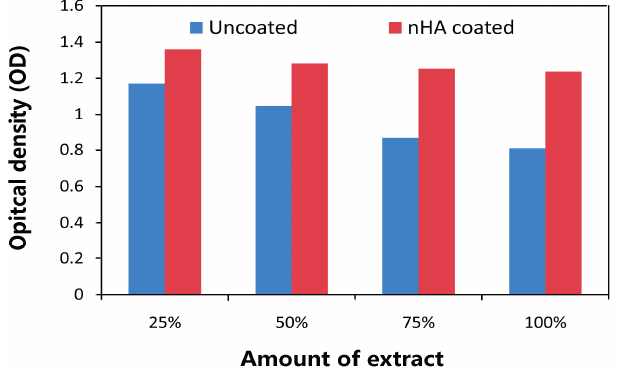
Figure 7. Cell viability cultured in individual extraction mediums of uncoated and nHA coated ZK60